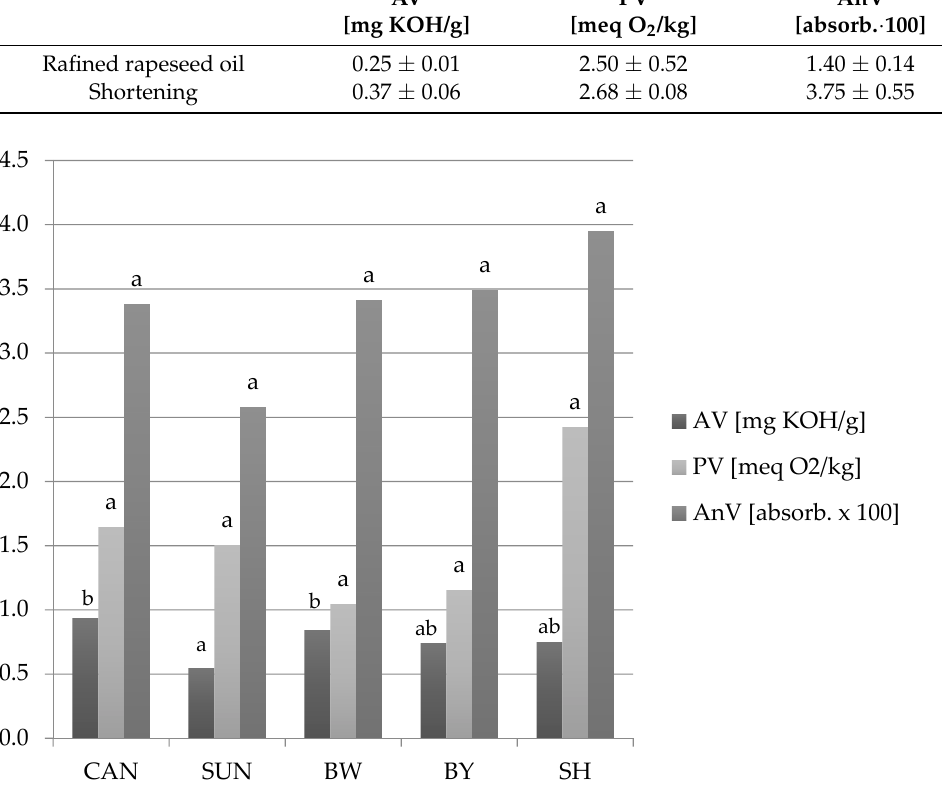
Figure 4. Acid (AV), peroxide (PV), and anisidine value (AnV) of lipid fractions extracted from gluten-free muffins with shortening (SH) or oleogel with: CAN—candelilla wax; SUN—sunflower wax; BW—beeswax white; BY—beeswax yellow; a, b—different letters above each type of column indicate statistical difference at α = 0.05.